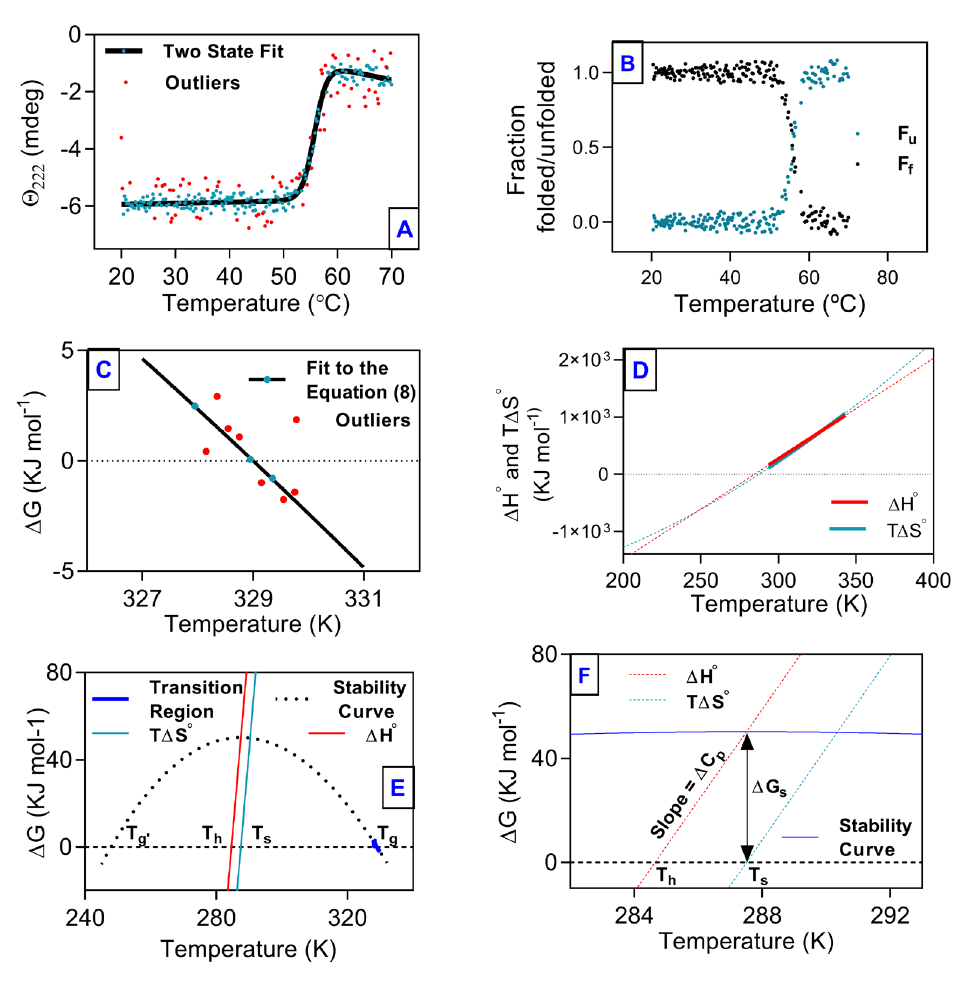
Figure 1. Thermal denaturation studies of human aldose reductase (hAR) monitored by far-UV circular dichroism. ( A ) Change in ellipticity at 222 nm plotted as a function of temperature. ( B ) The fraction of protein folded (black dots) and unfolded (cyan dots) plotted against temperature. ( C ) The portion of the transition curve used in van’t Hoff analysis. ( D ) Plots of Δ H and Δ S as a function of temperature. ( E ) Thermal stability curve of hAR. ( F ) Triangular relationship among T Dashed lines are extrapolations.The solid lines represent curves fitted to the unfolding transition; filled symbols represent data points from unfolding experiments; and red symbols represent